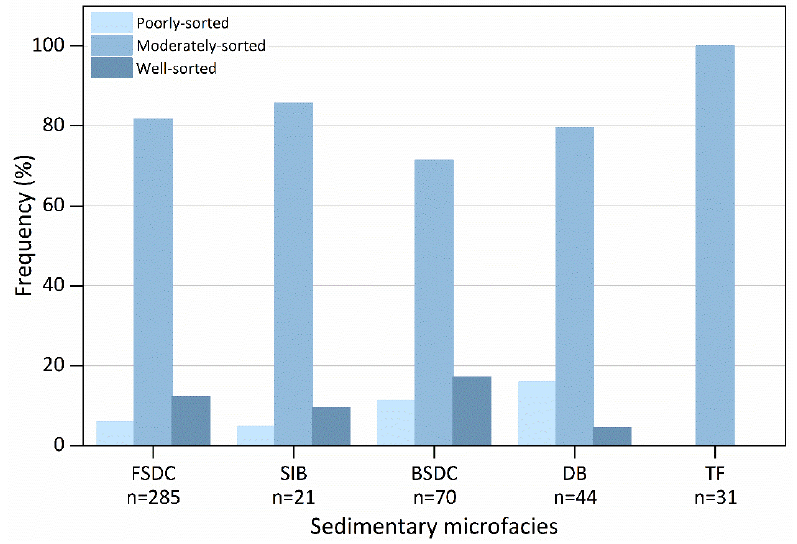
Figure 4. Sorting distribution of sandstones from each sedimentary microfacies, where “n” is the number of samples. (FSDC—submerged distributary channel (fan delta), SIB—submerged interdistributary bay, BSDC—submerged distributary channels (braided delta), DB—distal bar, TF—turbidite fan.).